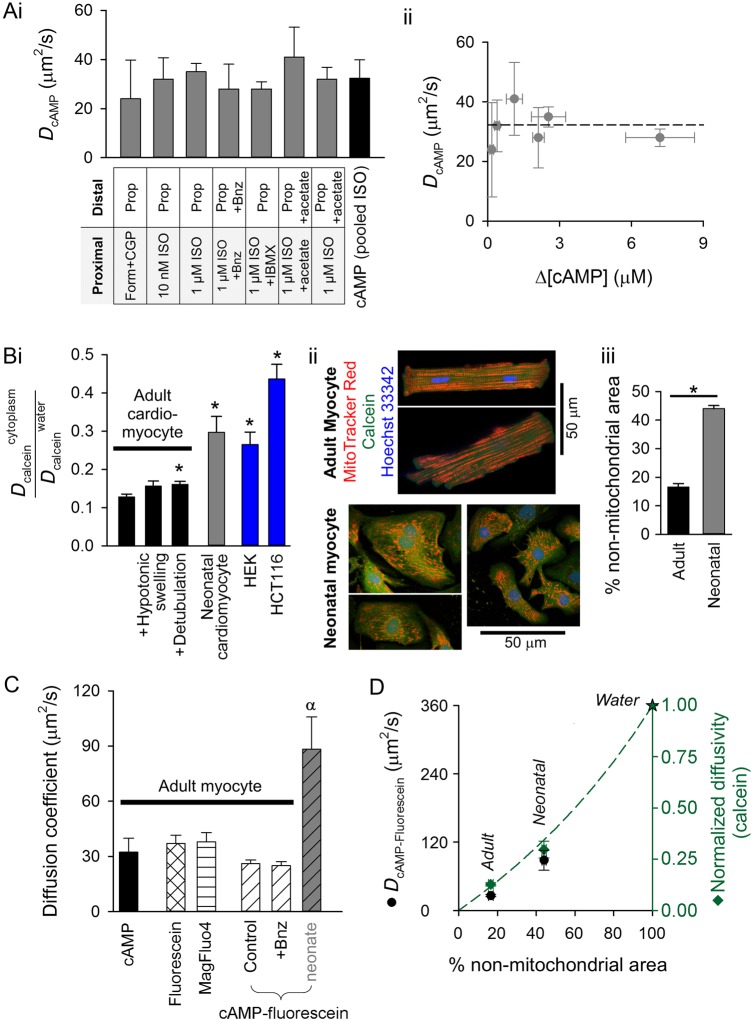
Cytoplasmic cAMP diffusivity in adult myocytes is comparable to that of similar sized molecules and is restricted by tortuosity. (A) (i) Summary of DcAMP measurements made by imposing [cAMP] gradients in adult myocytes by regional exposure to agonist. (ii) DcAMP is independent of the mean [cAMP]-rise evoked by regional exposure to agonist. (B) (i) Probing cytoplasmic tortuosity in terms of cytoplasmic calcein diffusion (measured by fluorescence recovery after photobleaching protocol) relative to calcein diffusivity in water (604 µm2/s). Measurements in adult cardiac myocytes under control conditions (n = 16/3), following hypotonic swelling (200 mOsm/kg solution; n = 14/3) or following detubulation with formamide (n = 14/3), and in HEK293 cells (n = 8) and HCT116 cells (n = 8). * denotes significant difference relative to adult cardiac myocyte (P < 0.05). (ii) Fluorescent staining of mitochondria (with MitoTracker Red), cytoplasm (with calcein), and nuclei (with Hoechst 33342) in adult or neonatal rat ventricular myocytes (excitation 555, 488, and 405 nm, respectively; emission collected at 580 ± 20, 520 ± 20, and 450 ± 20 nm). Mitochondrial distribution is more ordered and denser in adult myocytes compared with neonatal cells. (iii) Quantifying non-mitochondrial cell area. The mean intensity of MitoTracker Red fluorescence (Fmean) was measured in calcein-positive Hoechst 33342-negative pixels (i.e. non-nuclear cytoplasm). Non-nuclear cytoplasmic pixels with MitoTracker Red signals <0.5 × Fmean were defined as belonging to non-mitochondrial regions of the myocyte. The percentage of these pixels (relative to all non-nuclear cytoplasmic pixels) is lower in adult (n = 9/3) myocytes compared with neonatal (n = 12/3) myocytes, consistent with faster calcein diffusion in the latter. (C) Comparison of DcAMP (measured using dual microperfusion technique) with cytoplasmic diffusivity of the following fluorescent molecules (measured by FRAP): fluorescein (n = 8/3), MagFluo4 (n = 8/3), cAMP-fluorescein (n = 13/3) in control adult myocytes, cAMP-fluorescein (n = 12/3) in 5 µM 6-Bnz-cAMP-loaded adult myocytes, and cAMP-fluorescein diffusivity in neonatal myocytes (n = 6/4). Symbol α denotes significant difference (P < 0.05) relative to adult myocytes. (D) cAMP-fluorescein diffusivity (from C) and normalized calcein diffusivity (from Bi) plotted as a function of non-mitochondrial area fraction of myocyte (Biii). Star denotes diffusivity in water. Dashed line plots equation for diffusivity in tortuous medium, normalized to diffusivity in water: D/D0 = (2−2 × θ)/(2 + θ), where θ is the effective volume fraction of spherical impermeable inclusions.